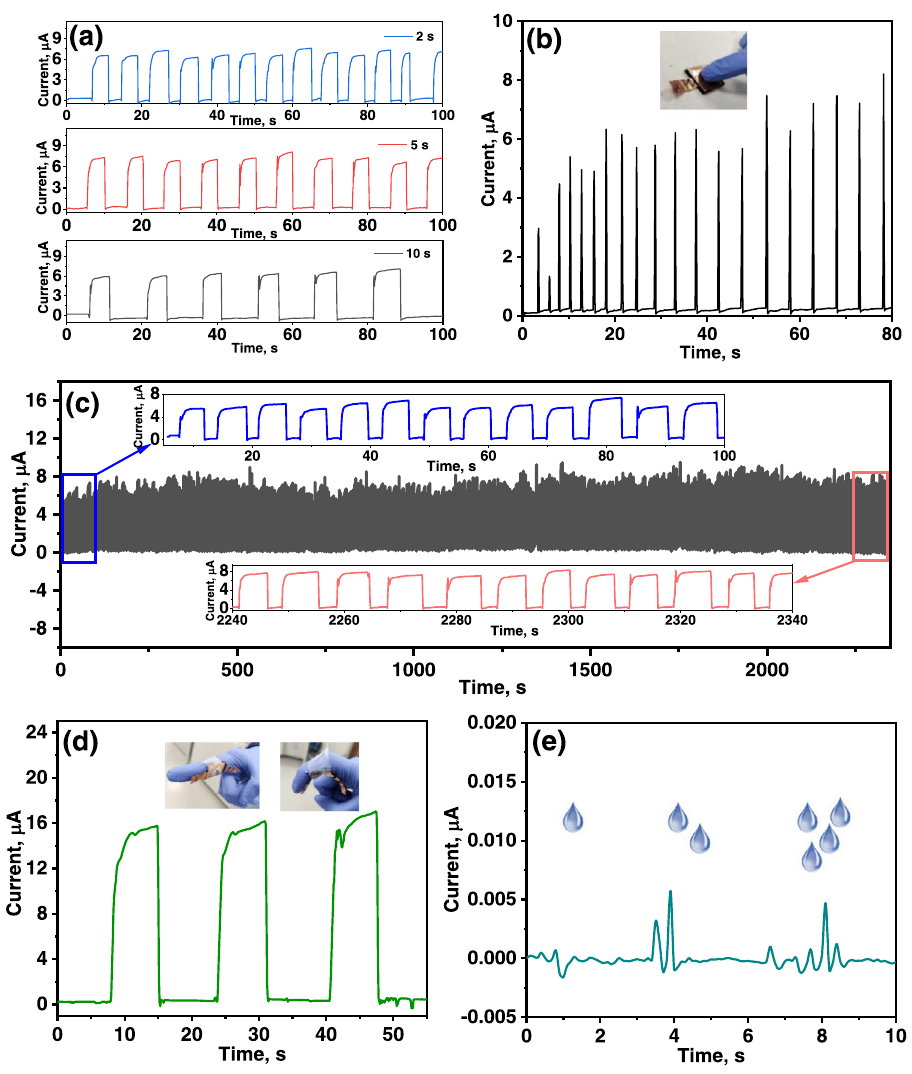
Fig. 4 | Real-world application. a Response curve with different speed applied pressure of 12 kPa. b Current response caused by fi nger touching on a sensor. c CyclingstabilityofBP@PANI-basedtactilesensoruponappliedpressureof12kPa